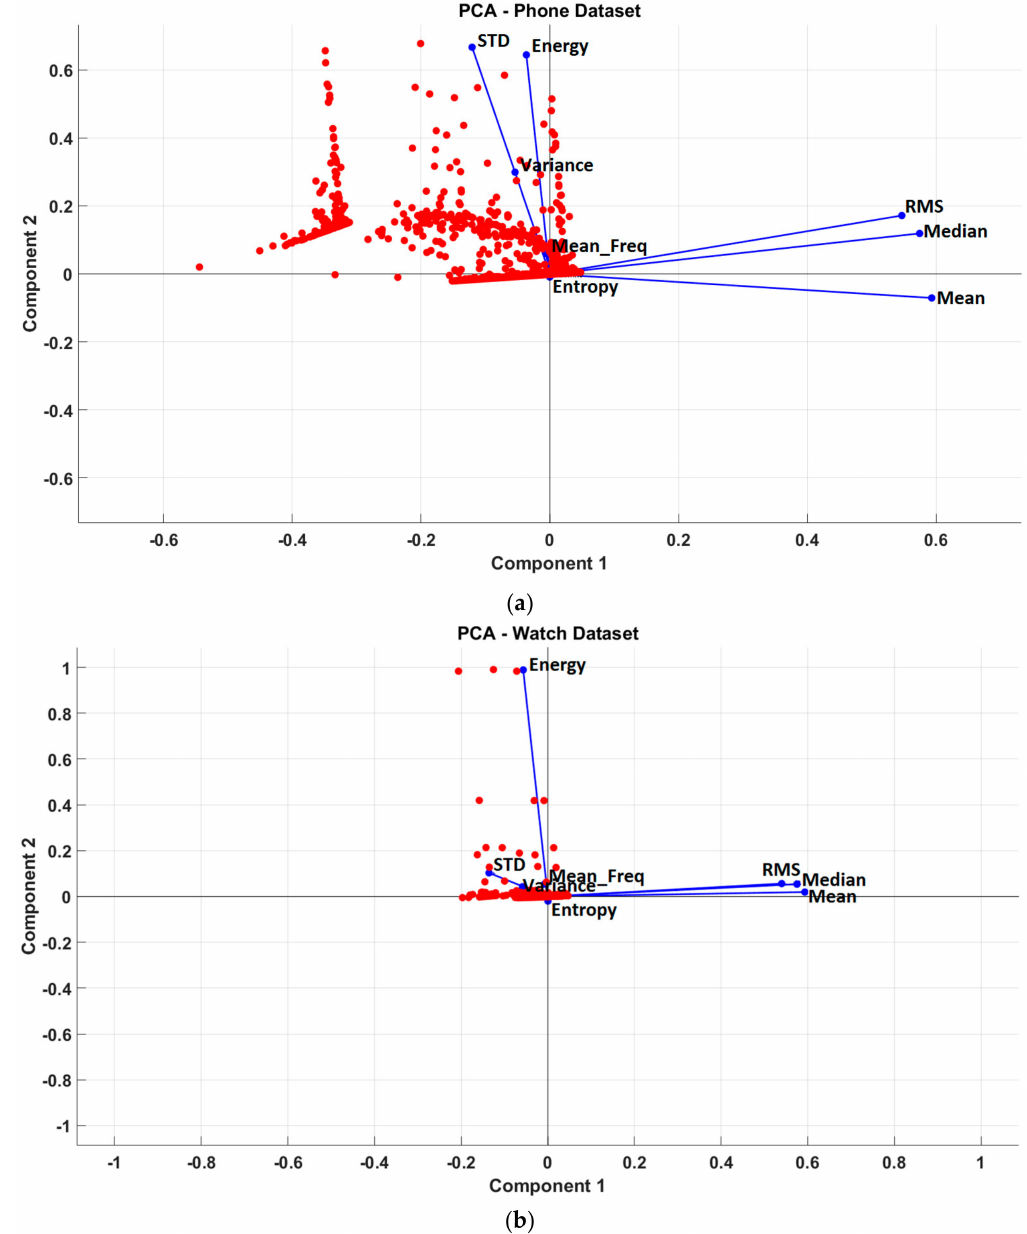
Figure 4. Principle component analysis graphs of the ( a ) Phone and ( b ) Watch datasets. PCA: principle component analysis; STD: standard deviation; RMS: root mean